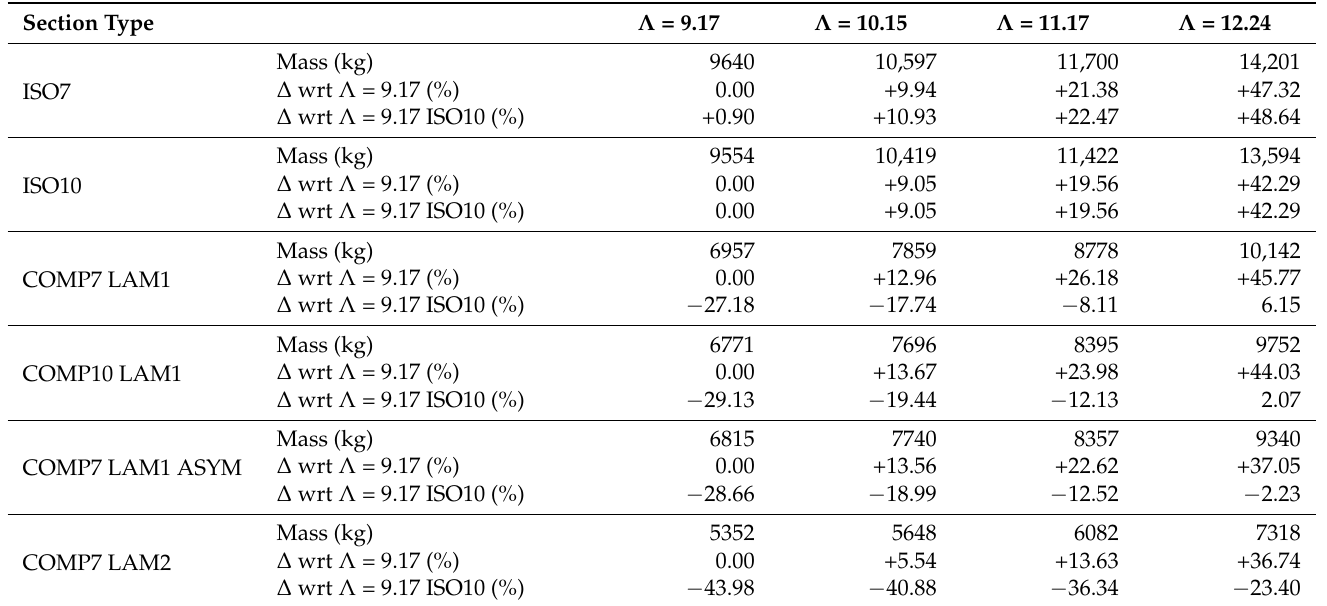
Table 8. Wingboxes mass and relative variation with respect to Λ = 9.17 with the same section layout and ISO10 layout.